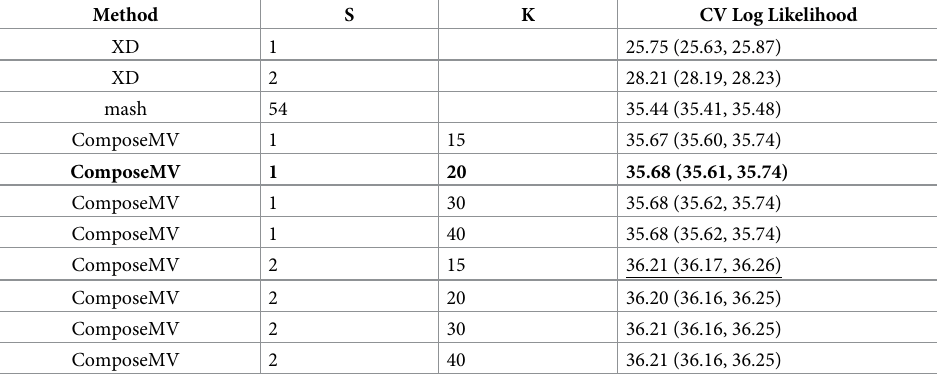
Table 9. Comparison of cross-validated log likelihood across MV models on the eQTL data from Urbut and col- leagues [22]. The largest CV log likelihood is underlined. The results shown are the per-sample log likelihood L ð c Þ (34) averaged across folds c = 1, ... ,10, along with ± 2 SEM intervals. Method S K